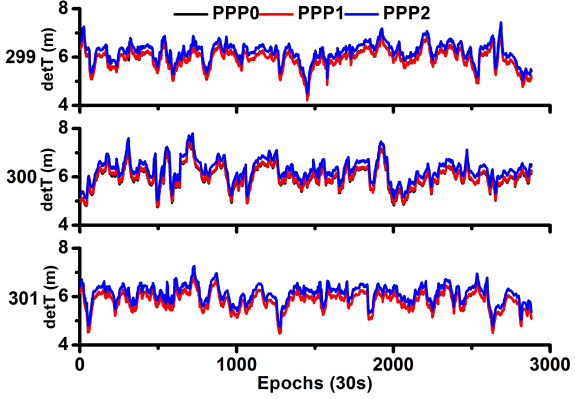
Figure 5. Comparison of time difference between different models.